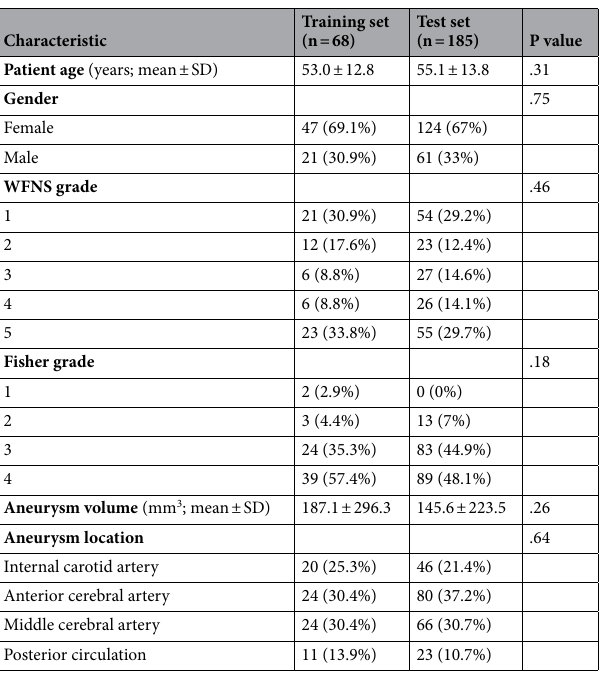
Table 1. Patient and aneurysm characteristics of training and test sets. WFNS = World Federation of Neurosurgical Societies. SD = standard deviation.